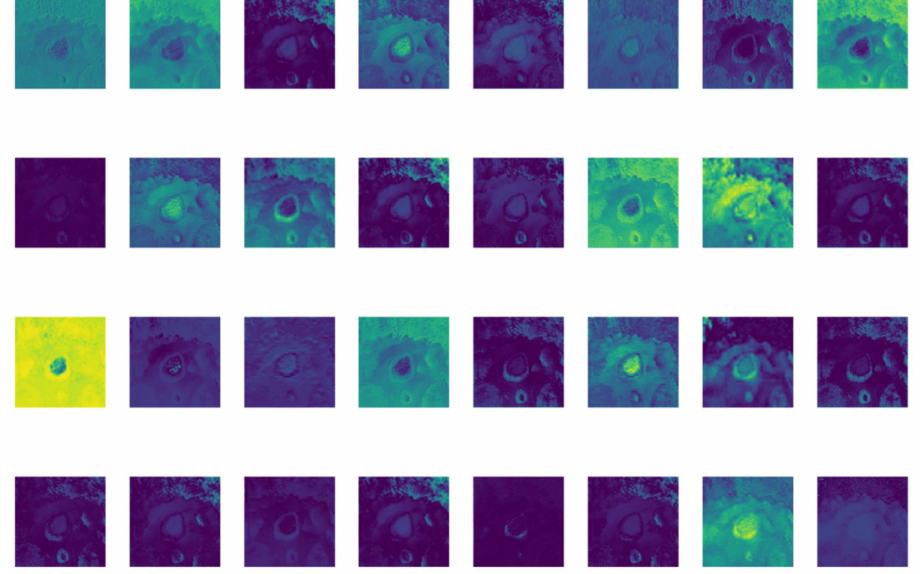
Figure 4. The visualization of the focus layer output.